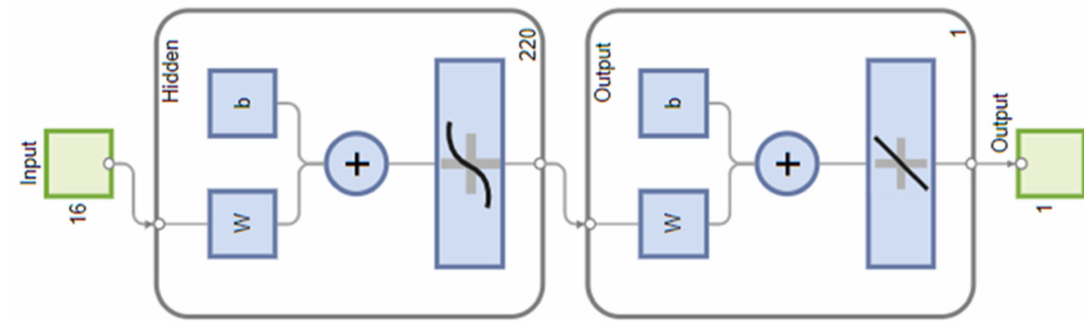
Figure 3. The ANN